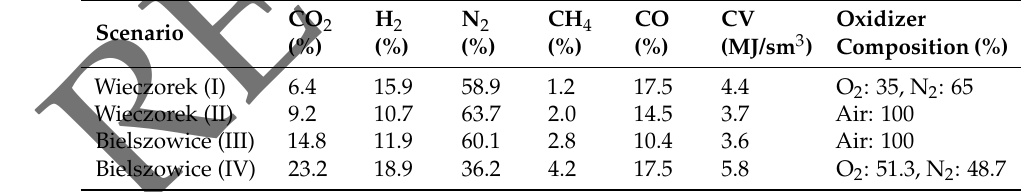
Table 17. Synthesis gas compositions and calorific values investigated in one-at-a-time (OAT) sensitivity analyses. Values given in% by volume, data for scenarios derived from Otto et al.